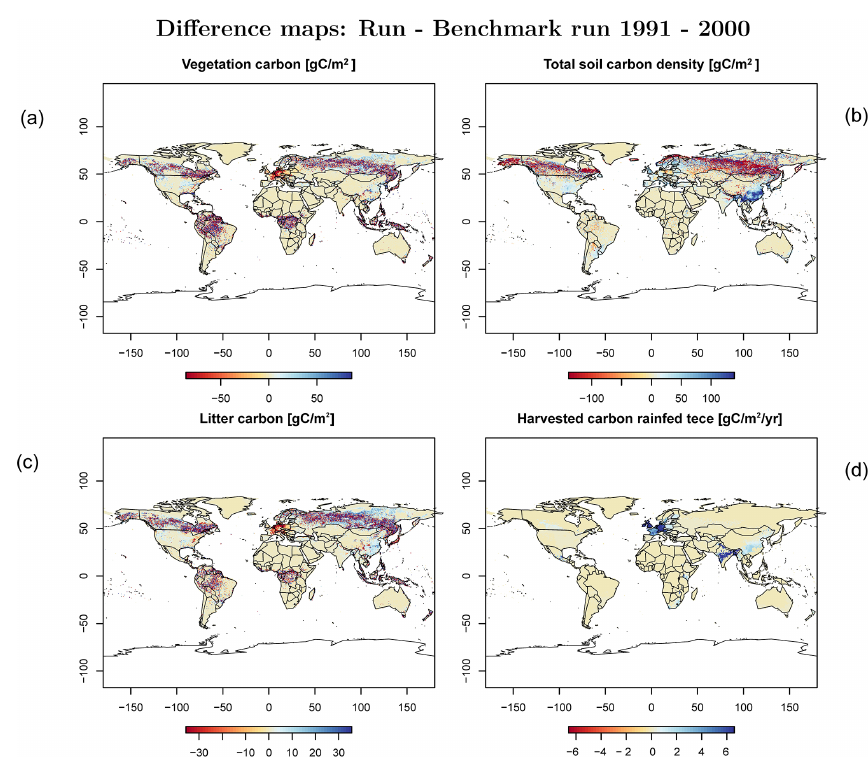
Figure C3. Difference maps of (a) vegetation carbon, (b) soil carbon, (c) litter carbon, and (d) harvested carbon of rainfed temperate cereals